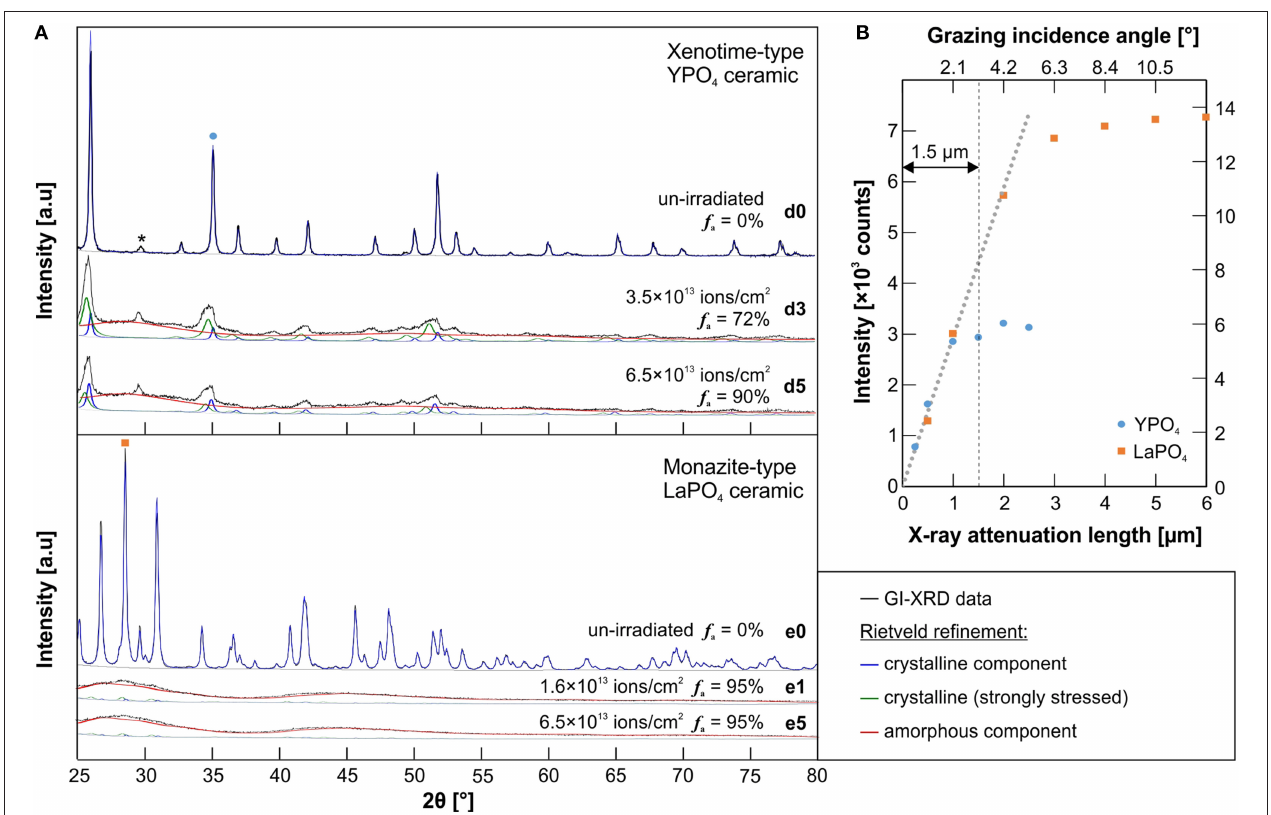
FIGURE 3 | (A) A graphical illustration of the Rietveld refinement applied to grazing-incident X-Ray diffraction patterns of un-irradiated and irradiated xenotime-type YPO 4 and monazite-type LaPO 4 ceramics (cp. Table 1 ). The glancing angle was set to 3.2 ◦ to probe a thin surface layer unto a depth of ∼ 1.5 µ m. In YPO 4 patterns, a minor diffraction peak at 2 θ ∼ 30 ◦ (marked with an asterisk) is attributed to a secondary phase (Y-stabilized tetragonal zirconia; Strasberg et al., 2014). To quantify the amorphous fraction f a , a refinement with three model phases have been applied: a fully crystalline component as observed from the un-irradiated sample (blue); a strongly stressed but still crystalline component (green); and an amorphous component refined with free lattice constants and very small grain-size factors (red). (B) The intensity of representative reflections of un-irradiated YPO 4 [(211) at 2 θ ≈ 35 ◦ , left-hand y-axis] and LaPO 4 ceramic [(120) at 2 θ = 28.6 ◦ , right hand y-axis] in dependence of various glancing angles that correspond to certain X-ray attenuation lengths calculated after Henke et al. (1993) (cp. Table 1 ). GI-XRD intensities of un-irradiated references samples saturate significantly above attenuation lengths > 2 µ m. An accurate probing depth of this method was accepted to be until ∼ 1.5 µ m below the surface for both